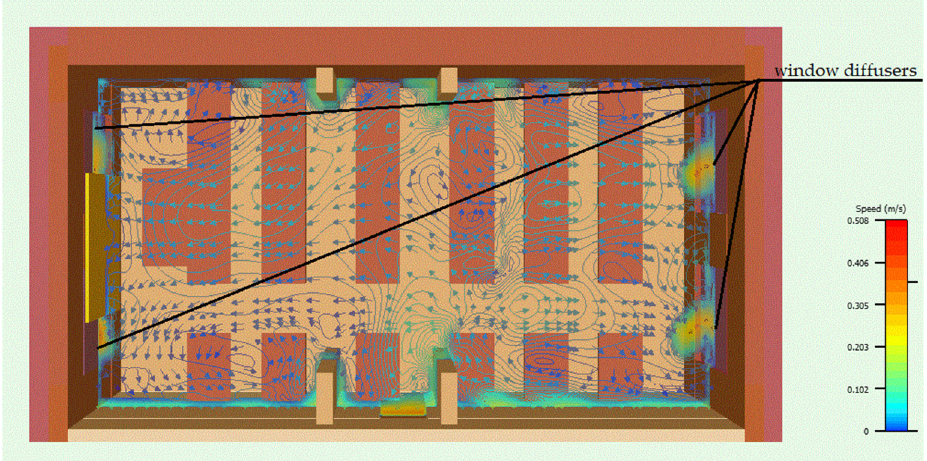
Figure 11. Visualized distribution of air velocities in a floor-parallel plane at the height of about 1.5 m; situation for the empty room at 3:00 PM—the natural air conditioning with window diffusers.